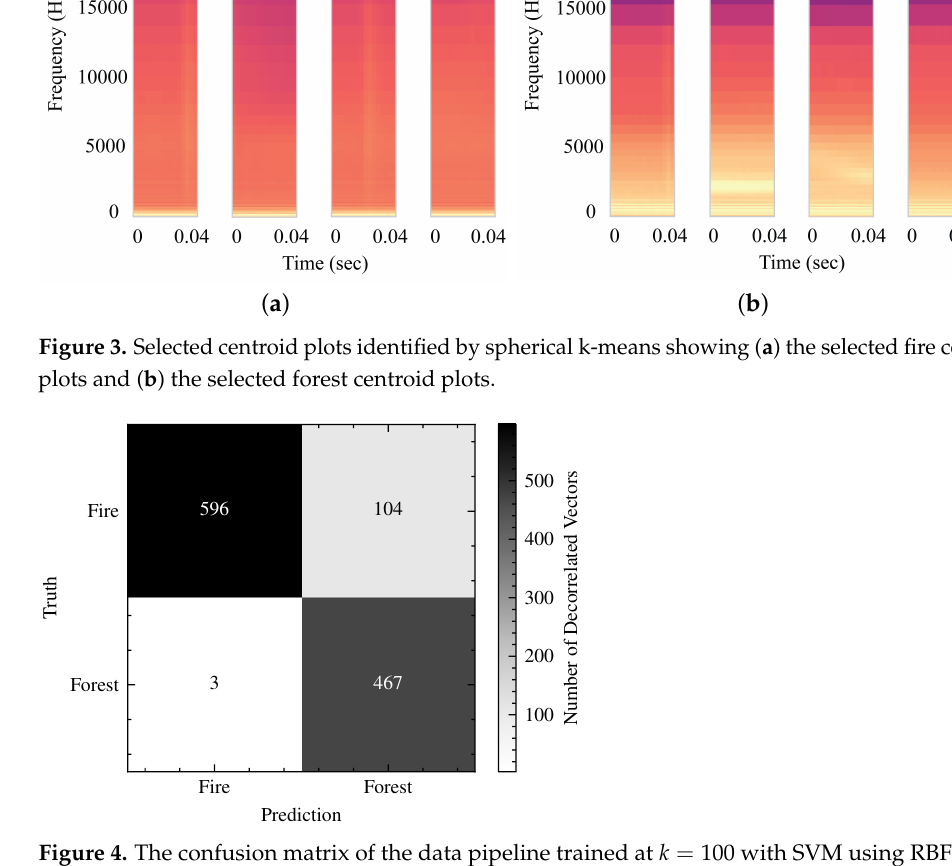
Figure 4. The confusion matrix of the data pipeline trained at k = 100 with SVM using RBF kernel and data augmentation. Note that the presented confusion matrix is the average of the confusion matrix across all 10-validation fold rounded to the nearest